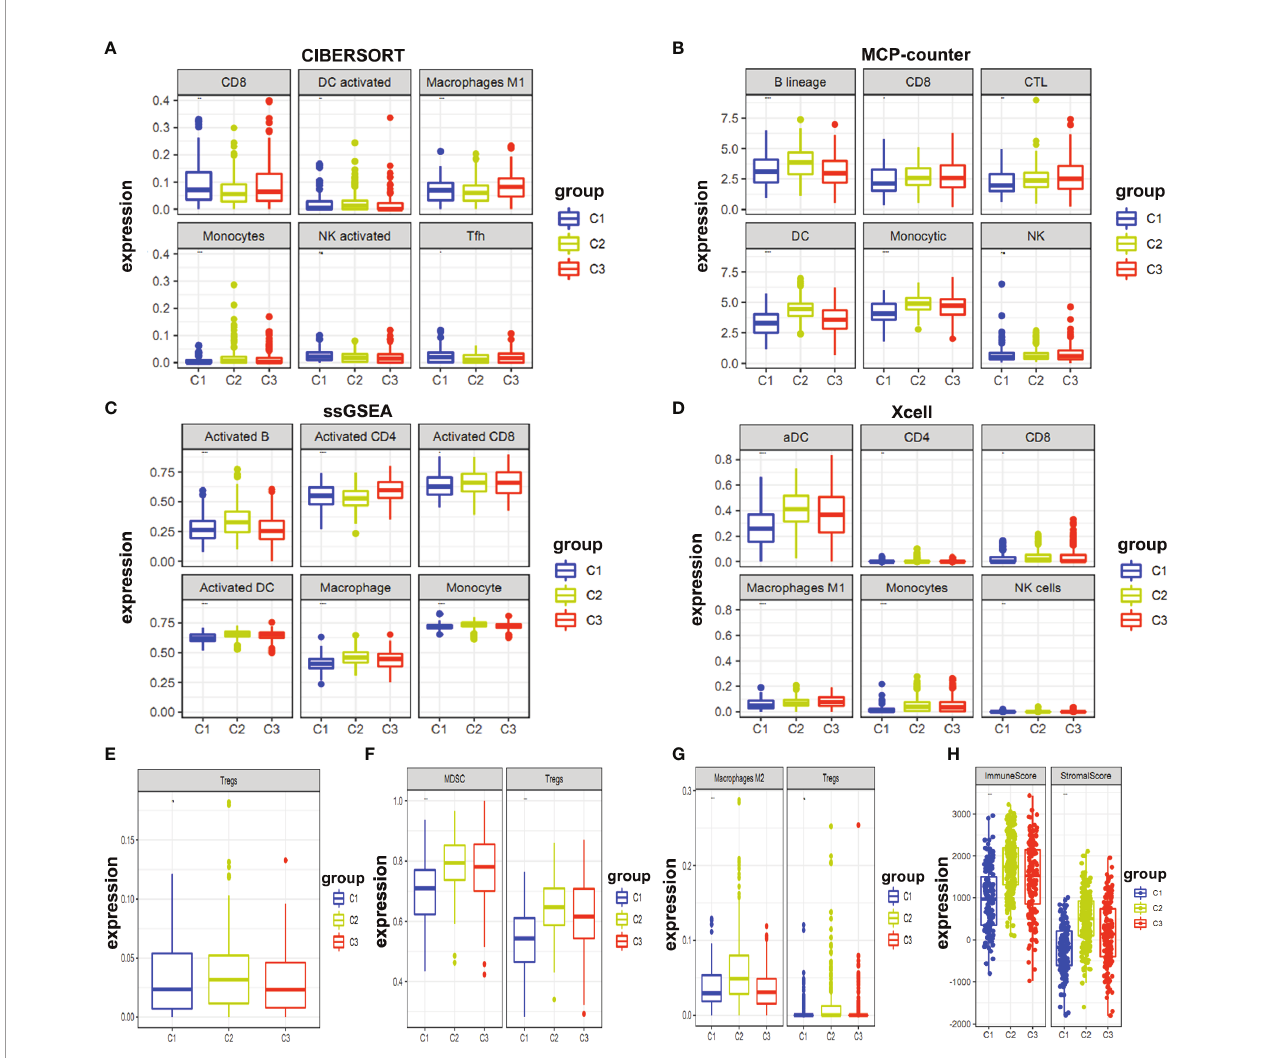
FIGURE 5 | Expression levels of immune in fi ltration cells. (A – D) Expression levels of immune effector cells between different clusters were shown; (E – G) Immunosuppressive cells in different clusters were shown; (H) Immune and stromal scores in different clusters were